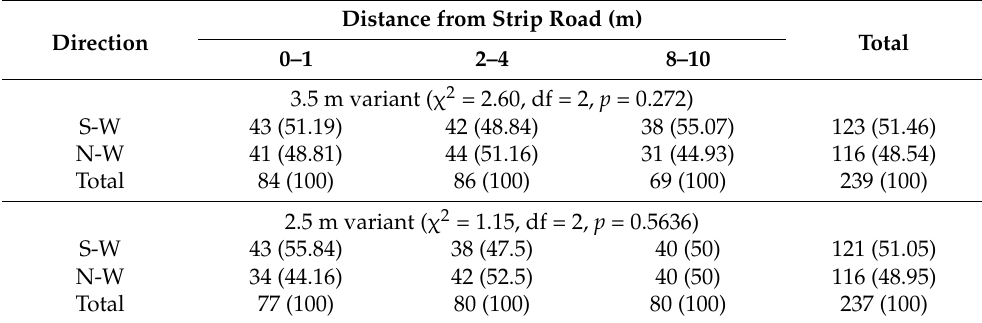
Table 5. Cross table (in brackets: %) and chi-square results for eccentricity directions (S-W, N-W) and distance from the strip road.